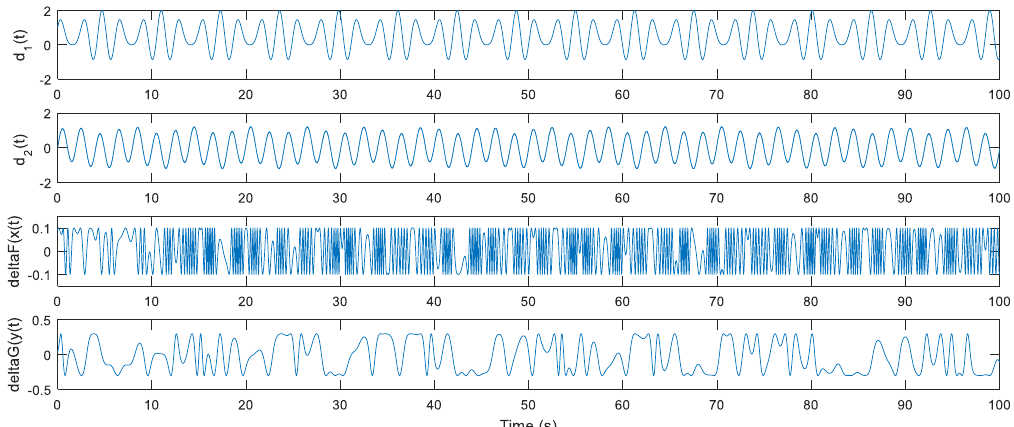
Figure 3. Disturbances ( d 1 ( t ) , d 2 ( t ) ) and uncertainties ( ∆ f ( x ( t ) , t ) , ∆ g ( y ( t ) , t )) in the master and slave systems (25), (26).